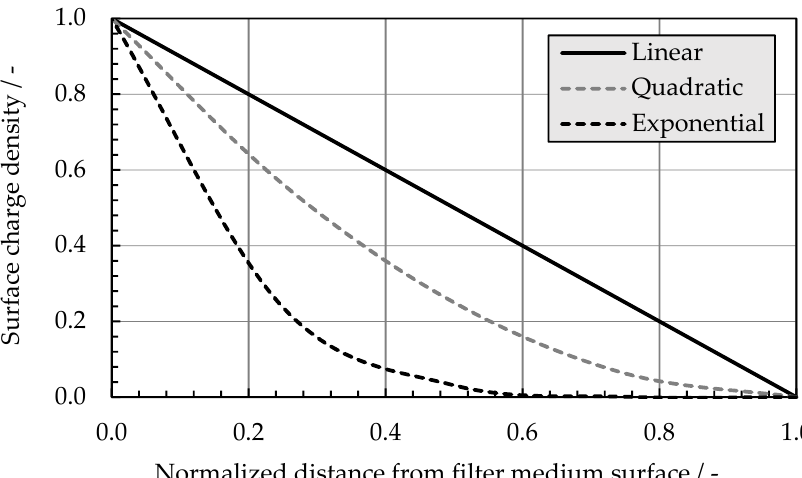
Figure 6. Decrease of electric charge magnitude from the filter medium surface to the middle of the fibrous structure.